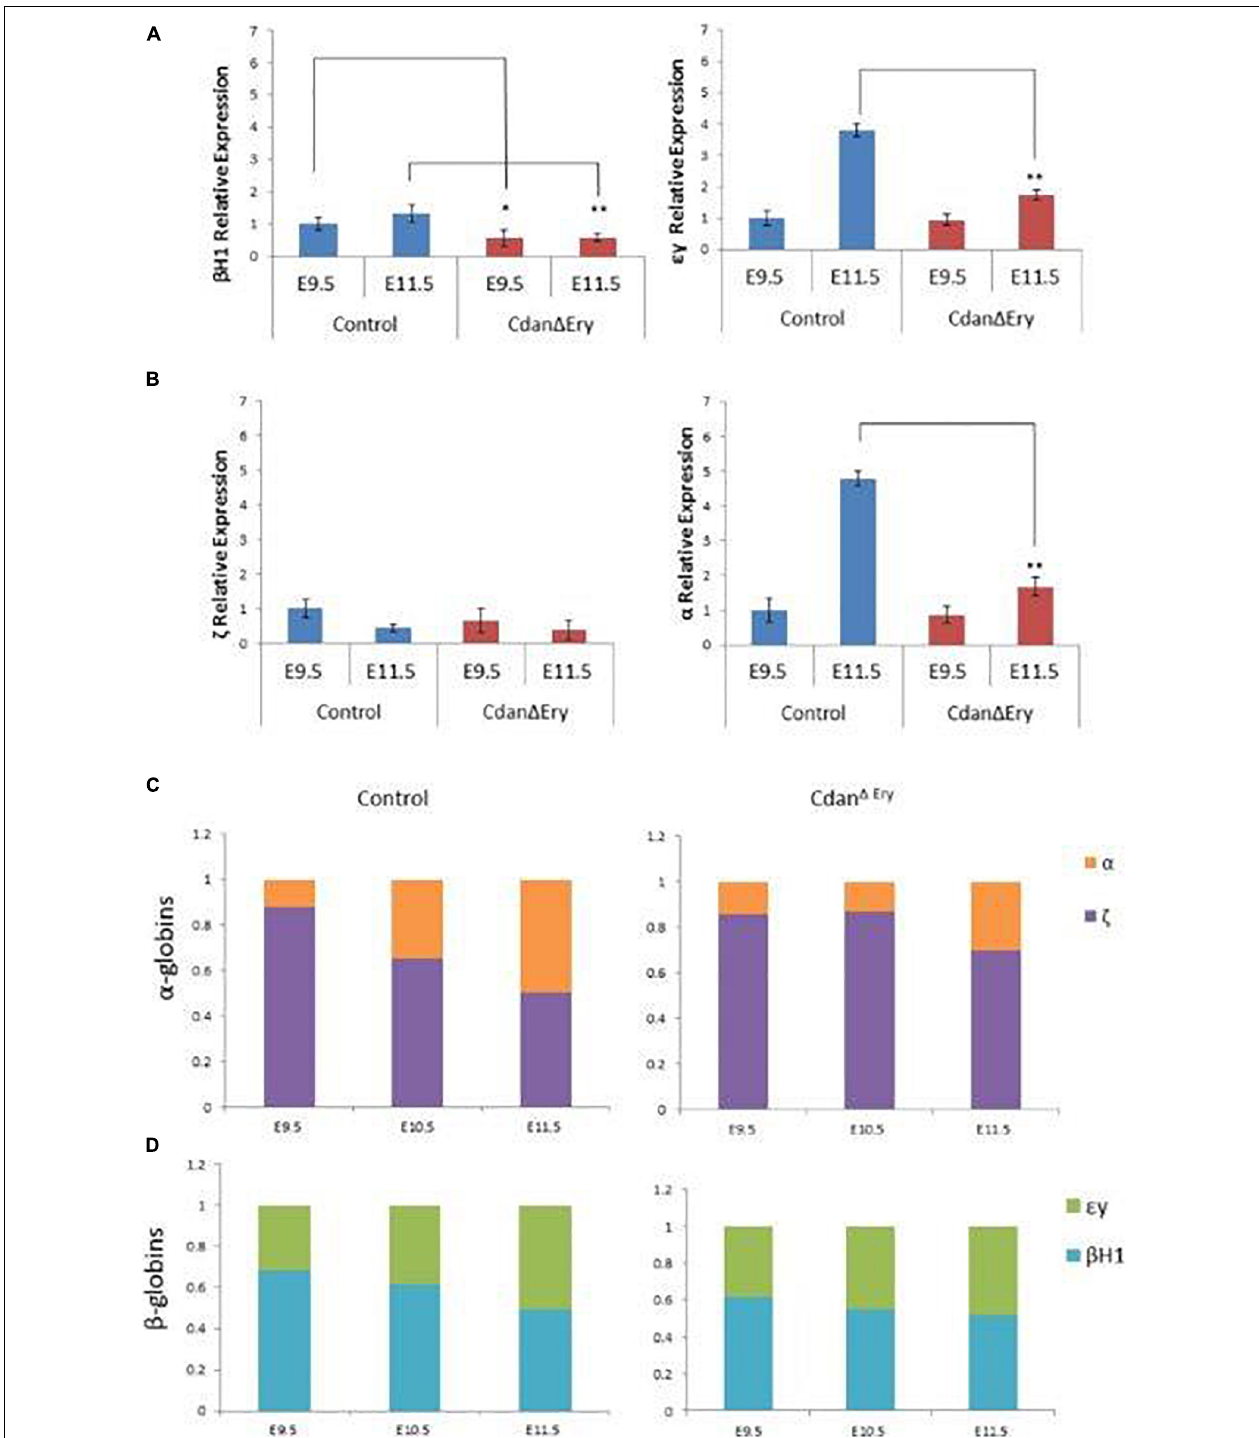
FIGURE 6 | Dysregulated embryonal globin expression in Cdan (cid:49) Ery erythroblasts. qRT-PCR was performed with peripheral blood at E9.5 and E11.5, and normalized to Rplp0. The relative expression of embryonic β -like globins (A) and embryonic α -like globin (B) are presented as mean ± SEM ( n = 4–6 for each genotype). The Student’s t- test was applied for statistical analysis. Asterisks indicate significant difference from the Control. * p < 0.01; ** p < 0.001. (C) α -globin switch is delayed in Cdan (cid:49) Ery erythroblasts. Expression of ζ and α was determined by RT-qPCR. The data are displayed as the fraction of total α -like globin (m ζ +m α ) expression. Embryonic day is indicated. (D) Expression of ε y, and β h1 was determined by RT-qPCR. The data are displayed as the fraction of total embryonal β -like globin (m ε y+m β h1) expression.